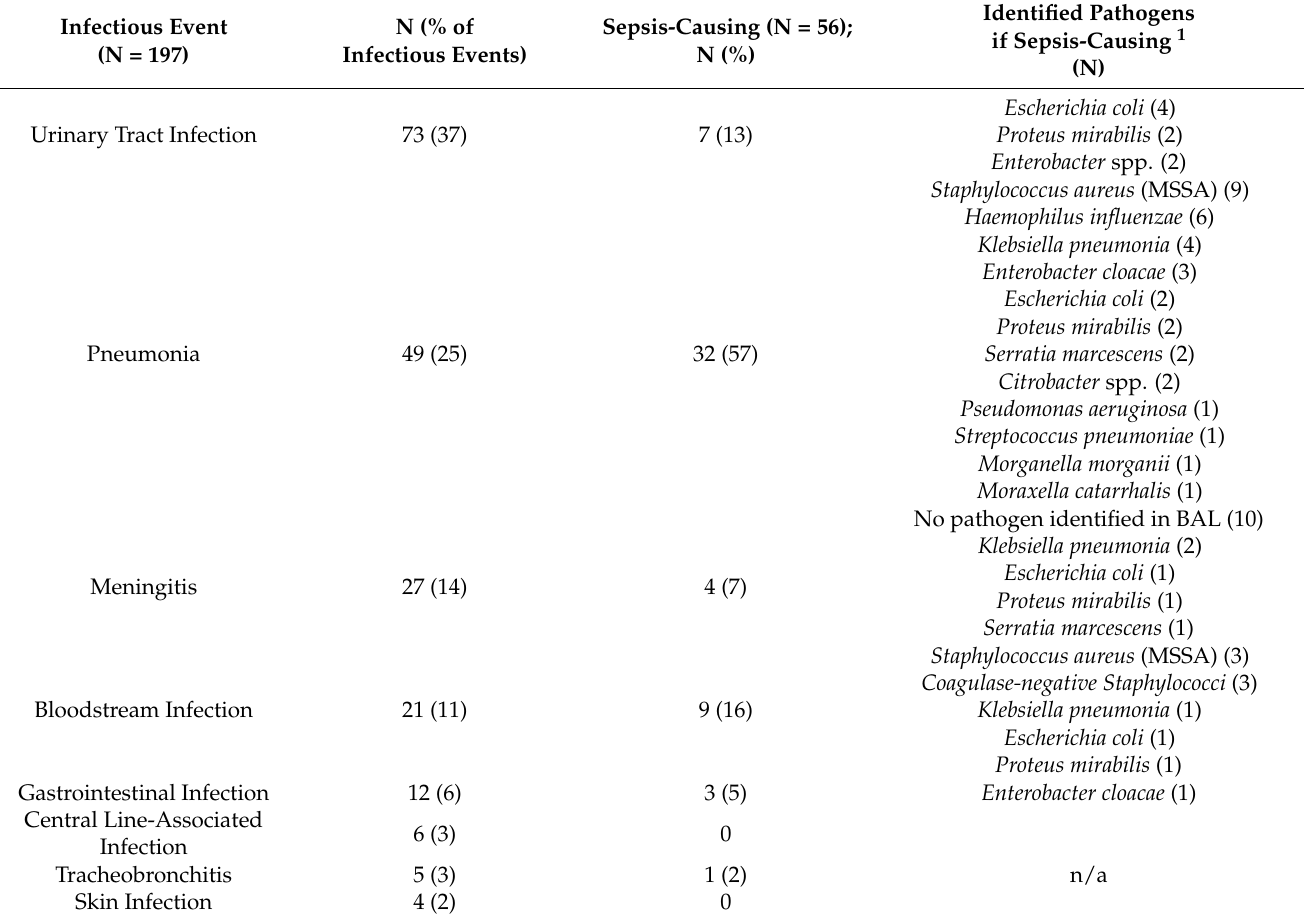
Table 4. Infectious events in study cohort and causing effect on sepsis when using alternative sepsis